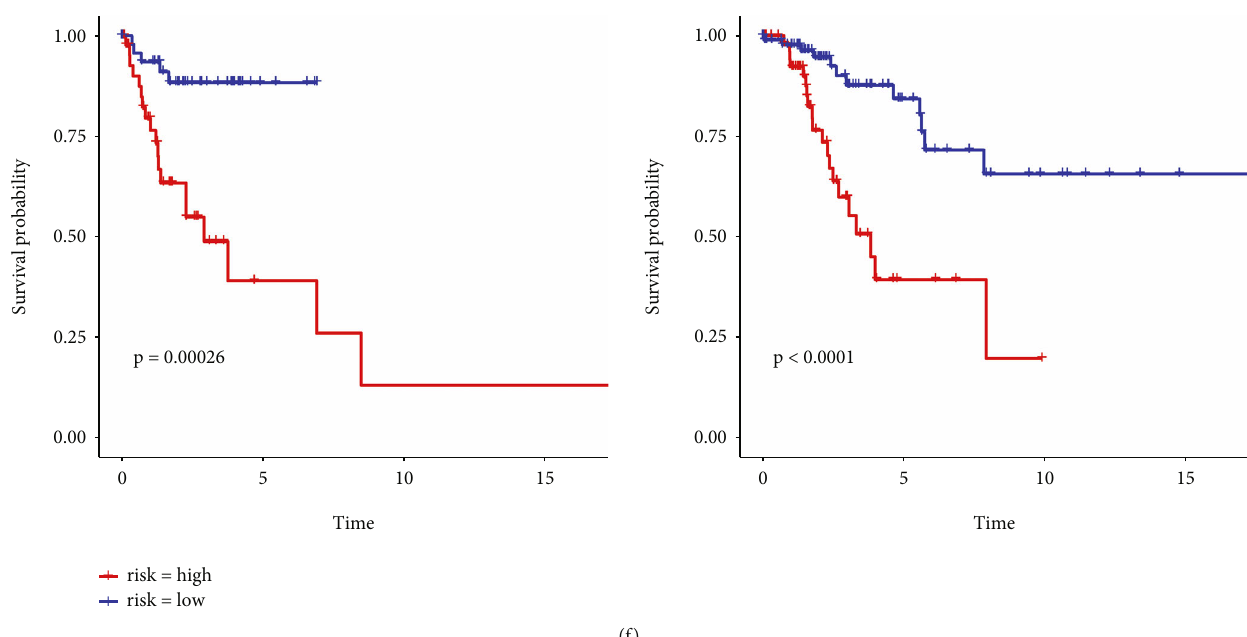
Figure 8: The potential relationship between risk score and clinical features in the TCGA dataset. (a) Relationship between the risk score and clinical signi fi cance (** P < 0 : 05 ). (b) KM survival curve of age. (c) KM survival curve of Figo_stage. (d) KM survival curve of Pathologic_ T. (e) KM survival curve of Pathologic_M. (f) KM survival curve of